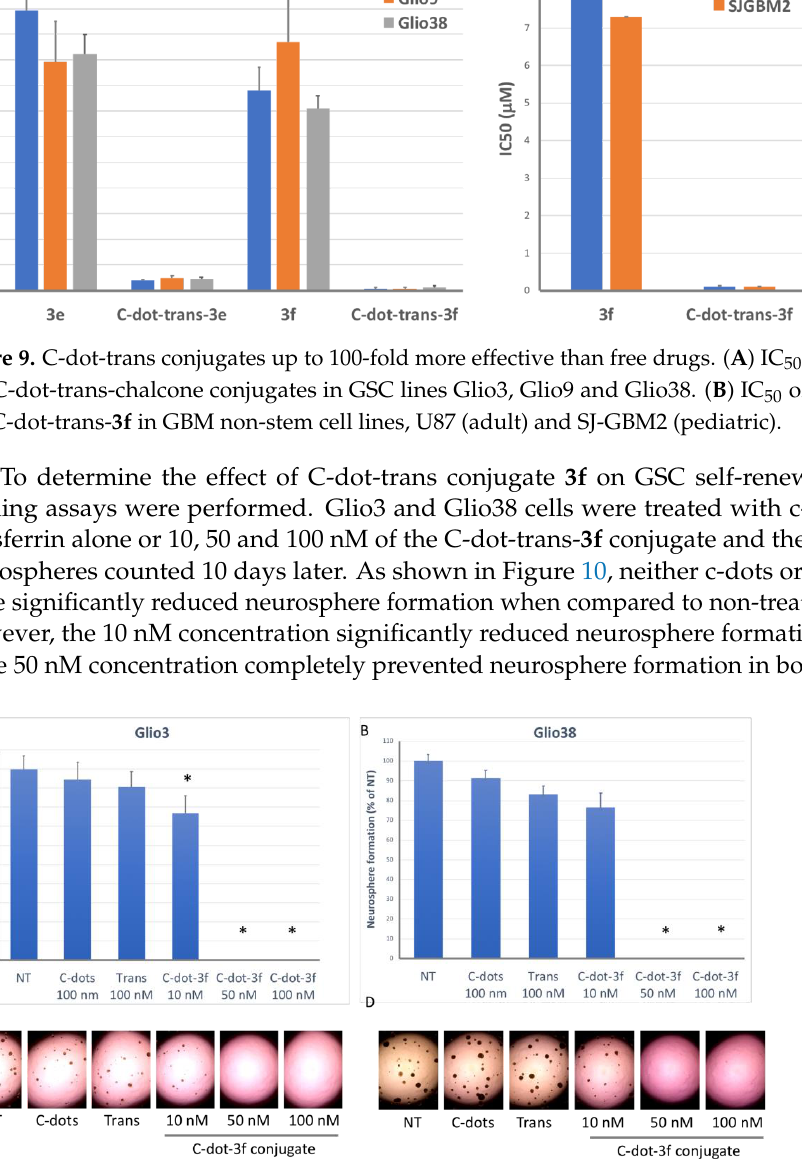
* p < 0.05 compared to non-treated controls. ( D ) Transferrin Re-